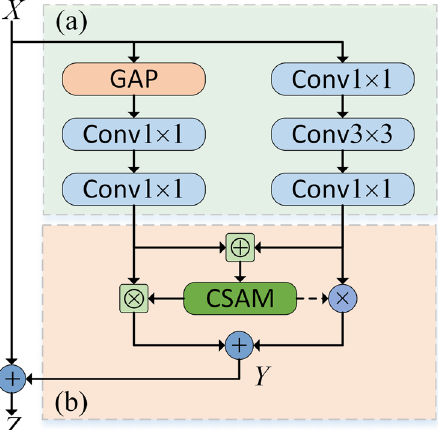
Figure 2: Context feature extraction module. ( a ) Multi - scale feature extraction, ( b ) attentional